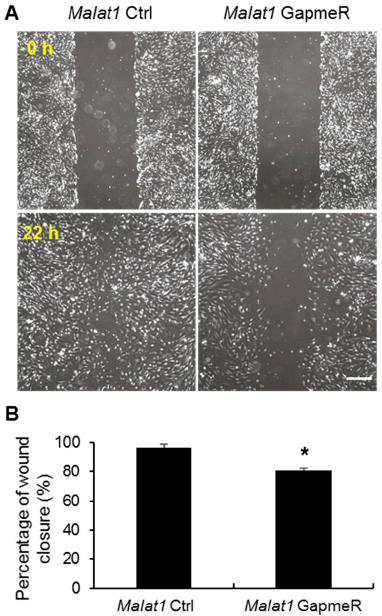
Figure 4. Malat1 silencing reduces cell migration in SMMECs. ( A ) Representative photomicrographs of in vitro wound healing assays. SMMCEs were transfected with either Malat1 control ( Malat1 Ctrl) or Malat1 GapmeR for 48 h in 6-multiwell plates. Wounds were produced in SMMECs by a yellow pipet tip, and photomicrographs were taken as time 0 h. After an additional 22 h of incubation, photomicrographs were taken again; and ( B ) Cellular migration was calculated by measuring the area occupied by the migrated cells. In comparison to Malat1 control ( Malat1 Ctrl) group, Malat1 silencing by GapmeR treatment in SMMECs significantly damped cell migration. Results are mean ± SEM of three independent experiments. * p < 0.05 vs. Malat1 Ctrl group. Scale bar represents 100 µm.